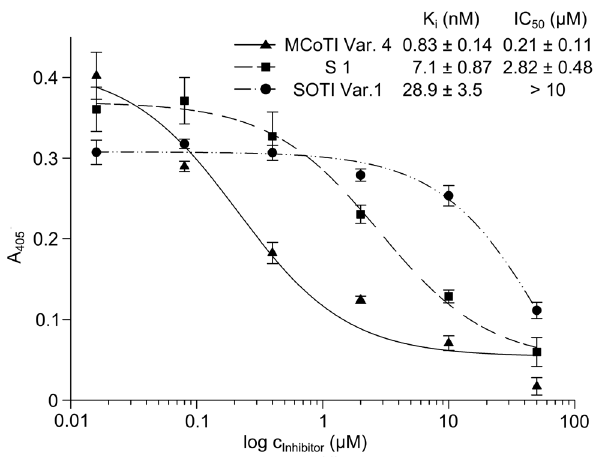
Figure 4. Inhibition assay of uPA activation by matriptase-1 on the surface of PC-3 cells. Depicted is the logarithmic inhibitor concentration against the absorption at 405 nm.